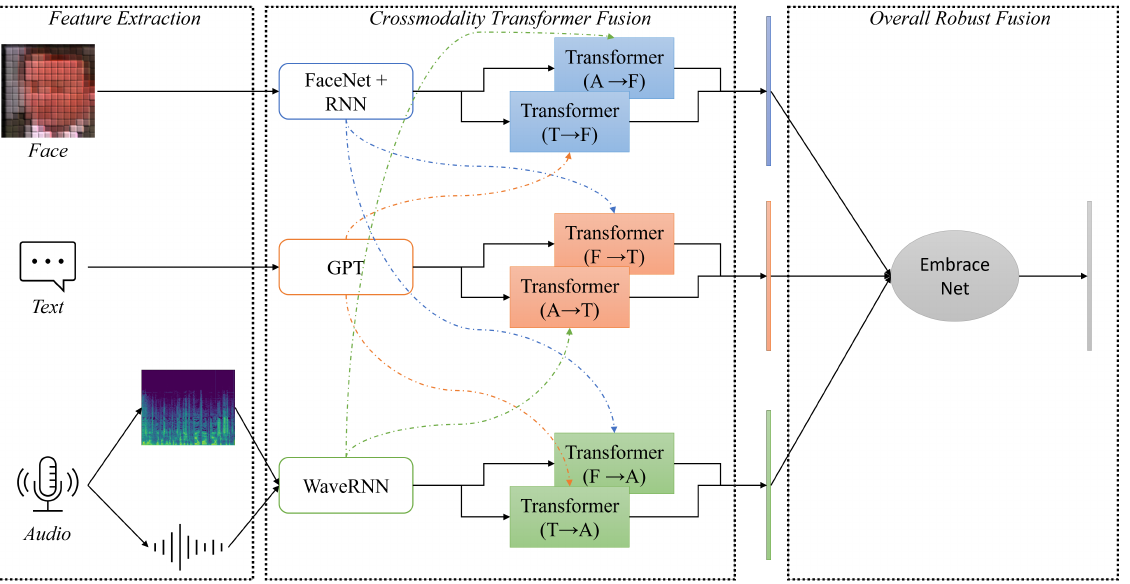
Figure 4. The crossmodal fusion transformer [40] with EmbraceNet